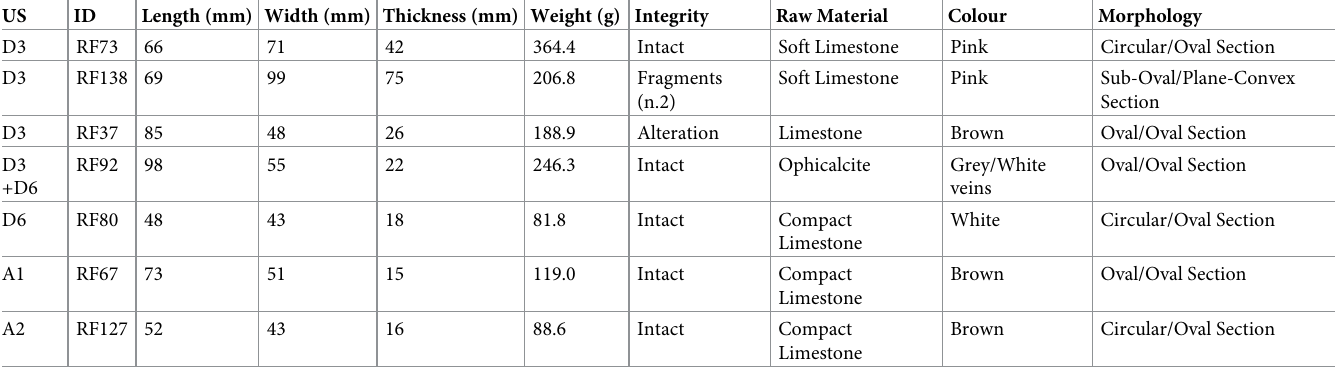
Table 1. Information on archaeological sample. US, dimensions, raw material, integrity, colour and morphology. US ID Length (mm) Width (mm) Thickness (mm) Weight (g)